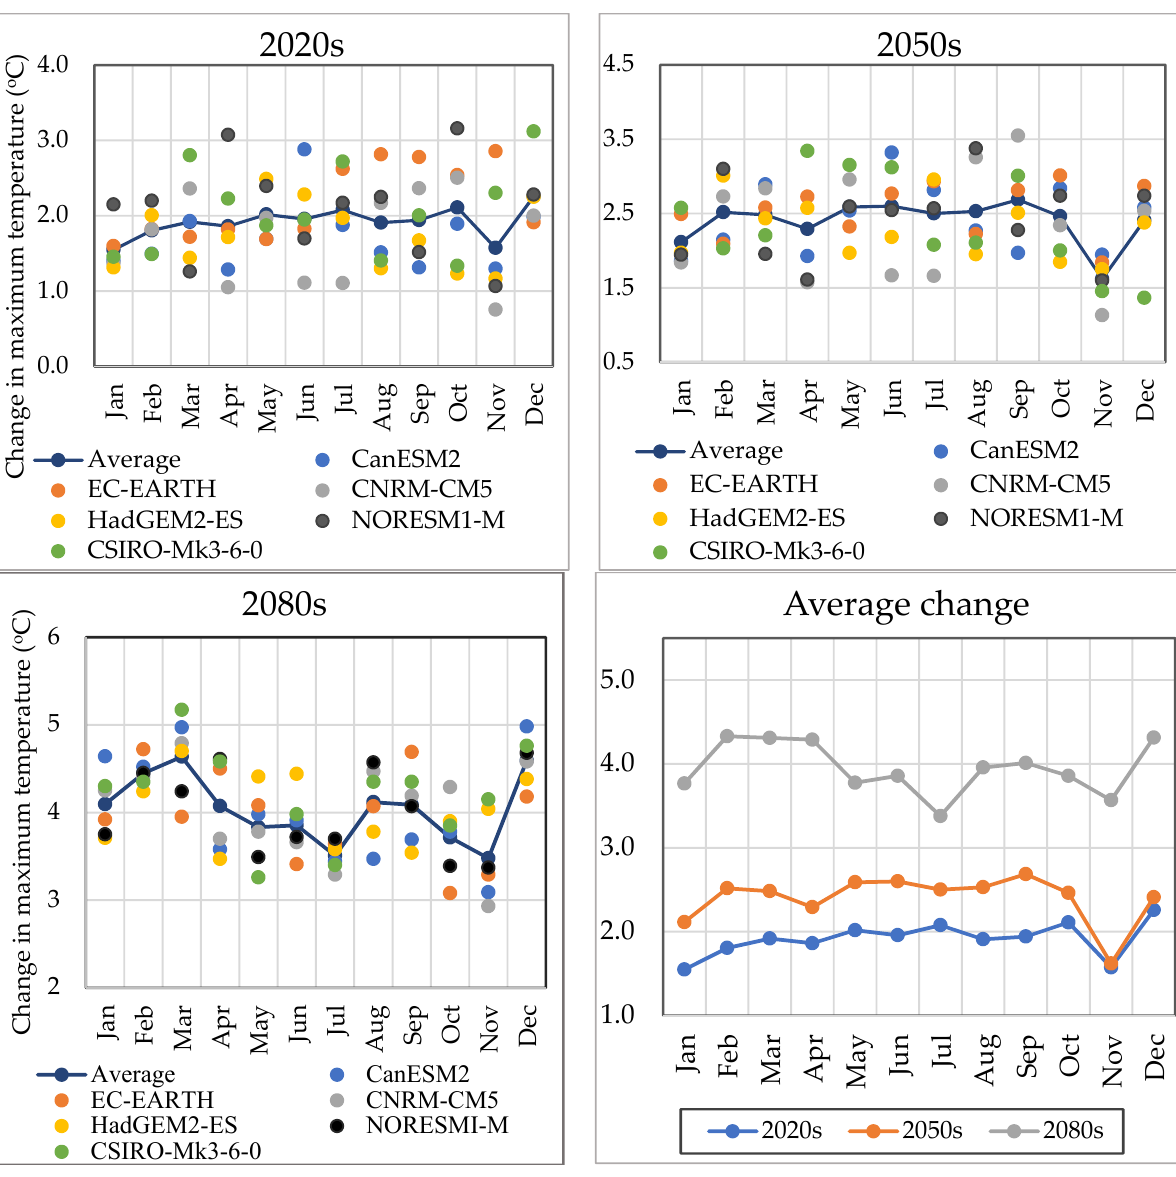
Figure 2. Change in maximum temperature in 2020s, 2050s, and 2080s including the average change in all climate models.